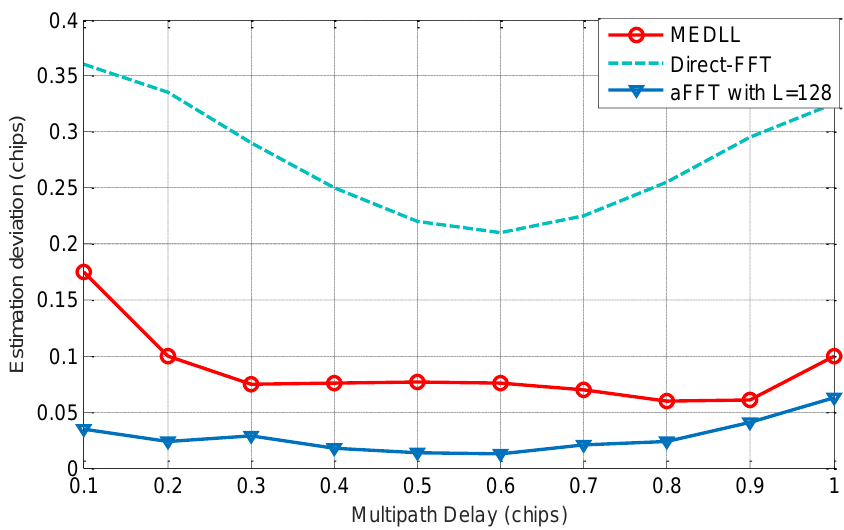
Figure 5. Estimation deviation of estimated code delay with τ varying from 0.1 to 1 chip.